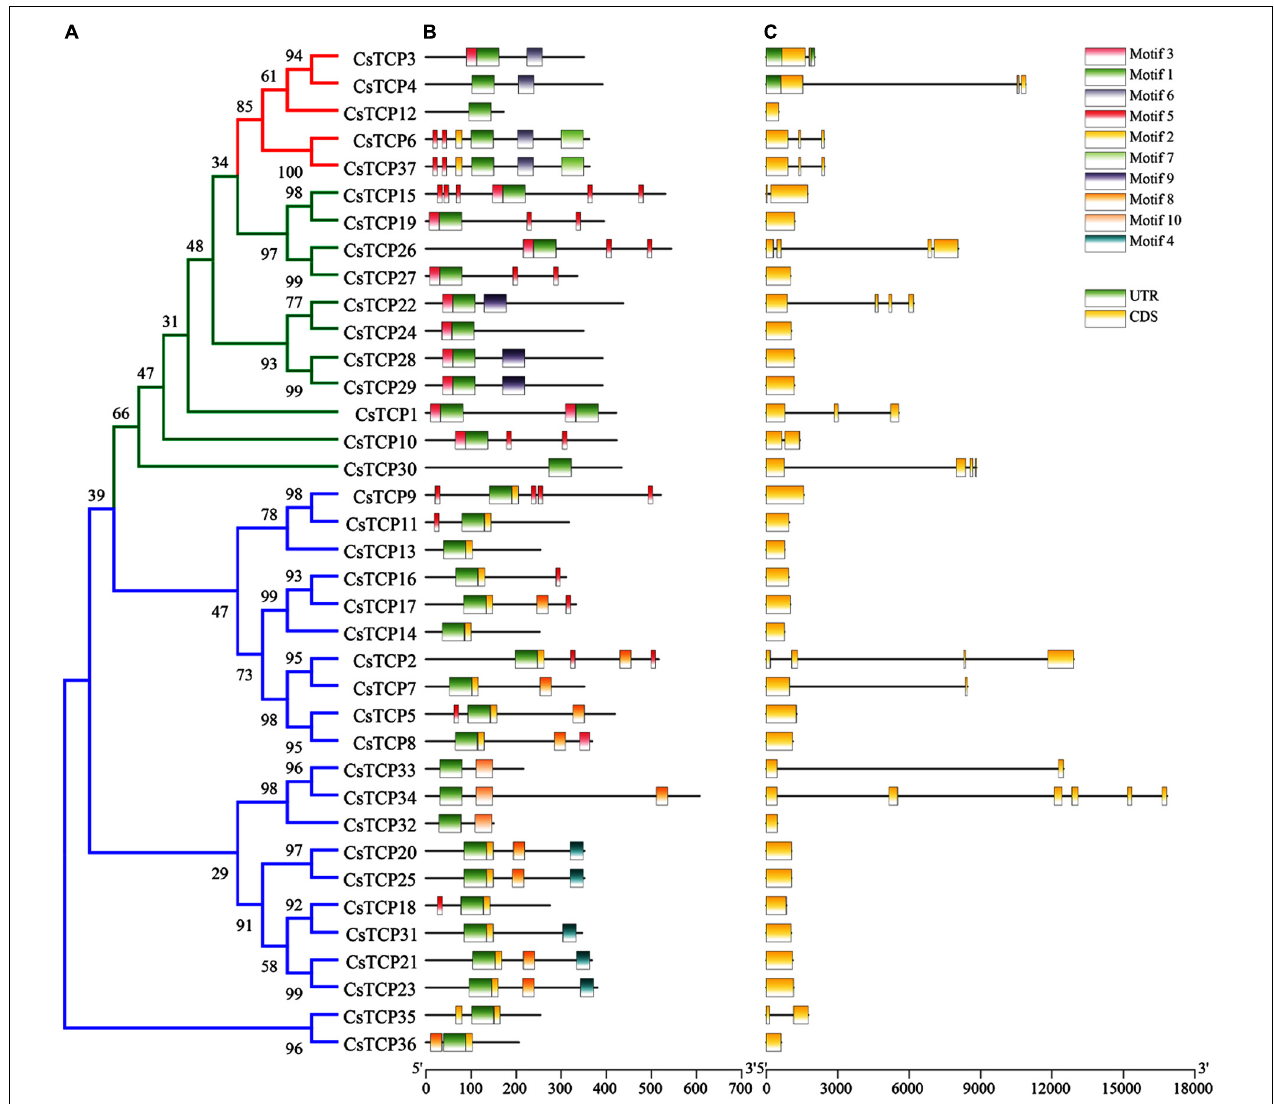
FIGURE 3 | CsTCP protein and gene sequences analysis. (A) Phylogenetic tree (ML), the blue line represents the PCF group, the green line represents the CIN group, and the red line represents the CYC/TB1 group; (B) motif analysis; (C) gene structure analysis, horizontal lines indicate introns.